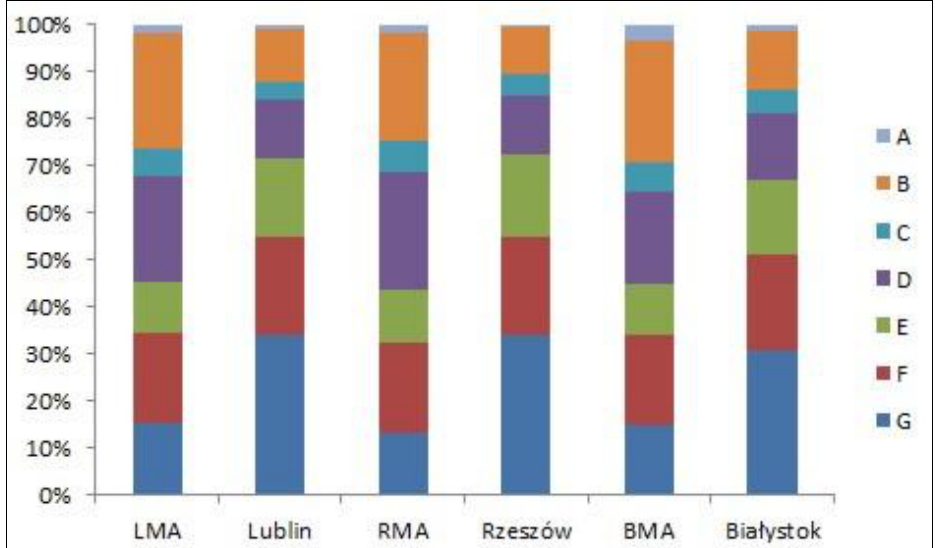
Fig. 12. Education of the population in the Białystok, Lublin, and Rzeszów Metropolitan Area (2011)